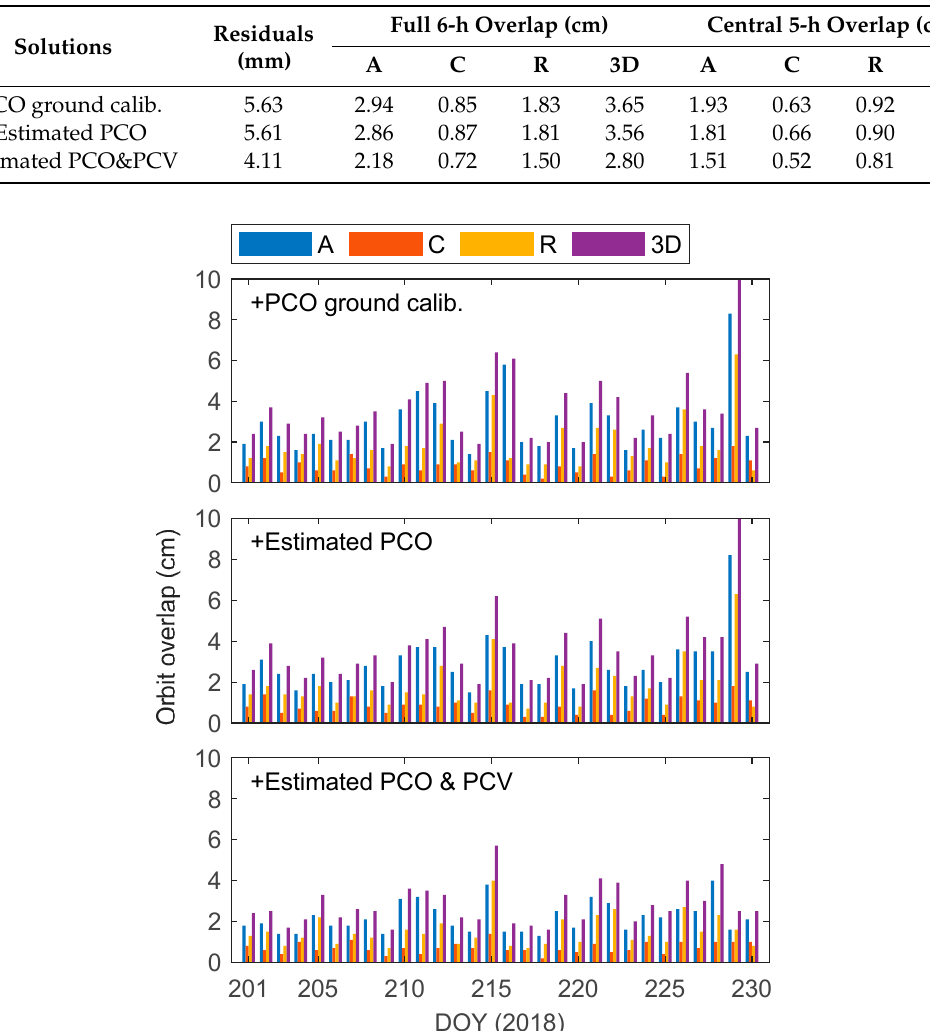
Figure 10. Root mean square (RMS) of full 6-h orbit overlap differences in the along-track, cross-track, radial directions and in 3D for GPS-only solutions. The top, middle and bottom panels show the results obtained with only PCO ground calibration, with PCO estimation, and with both estimated PCO and PCV map, respectively.